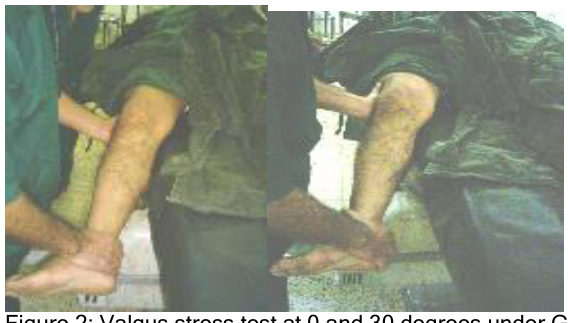
Figure 2: Valgus stress test at 0 and 30 degrees under GA.